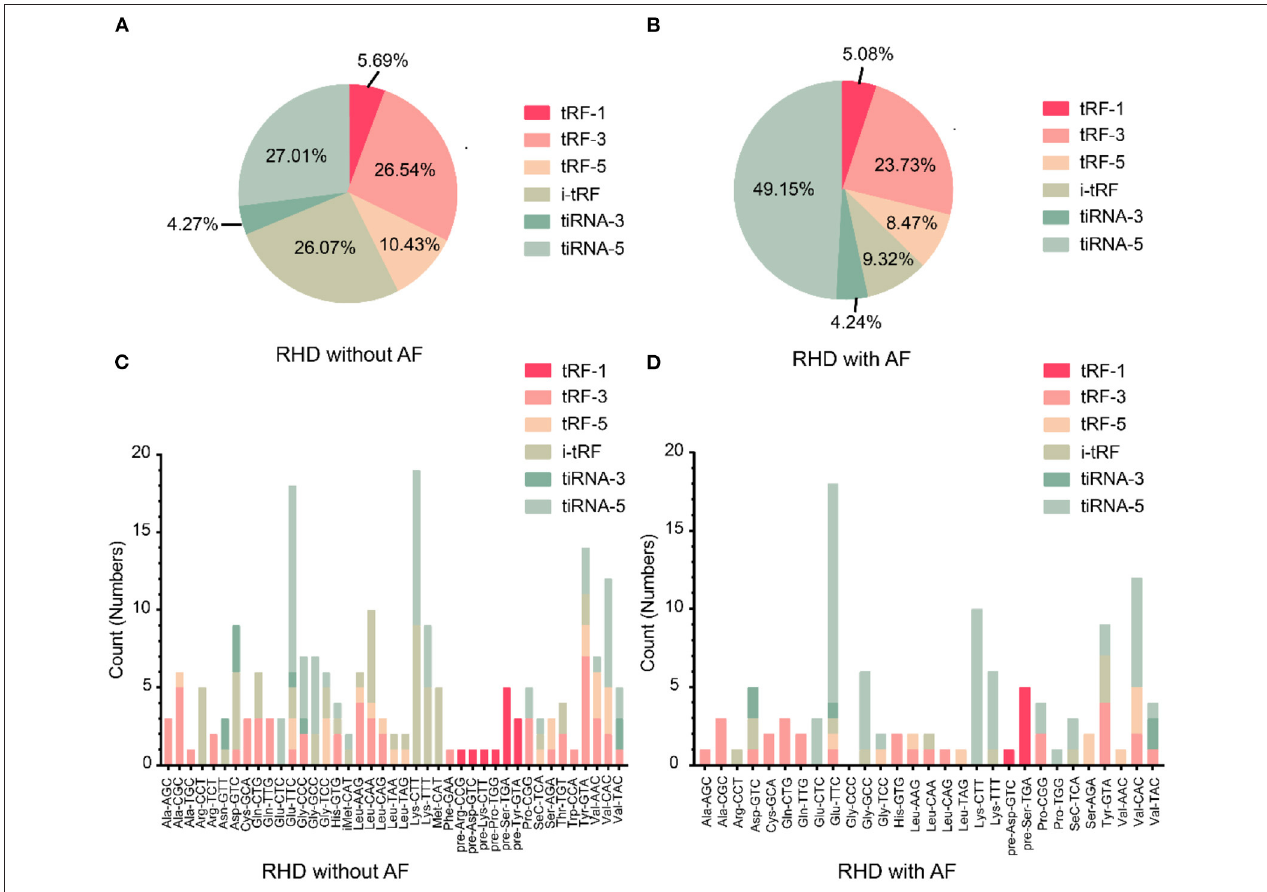
FIGURE 2 | Differences and characterizations of tsRNAs expression profiles between two groups. (A,B) Pie chart of the distribution of subtypes of tsRNAs numbers in RHD without AF (A) and RHD with AF (B) . (C,D) Stacked plot for all subtypes of tsRNAs of each group clustering by the same anticodon of the tRNAs in RHD without AF (C) and RHD with AF (D)